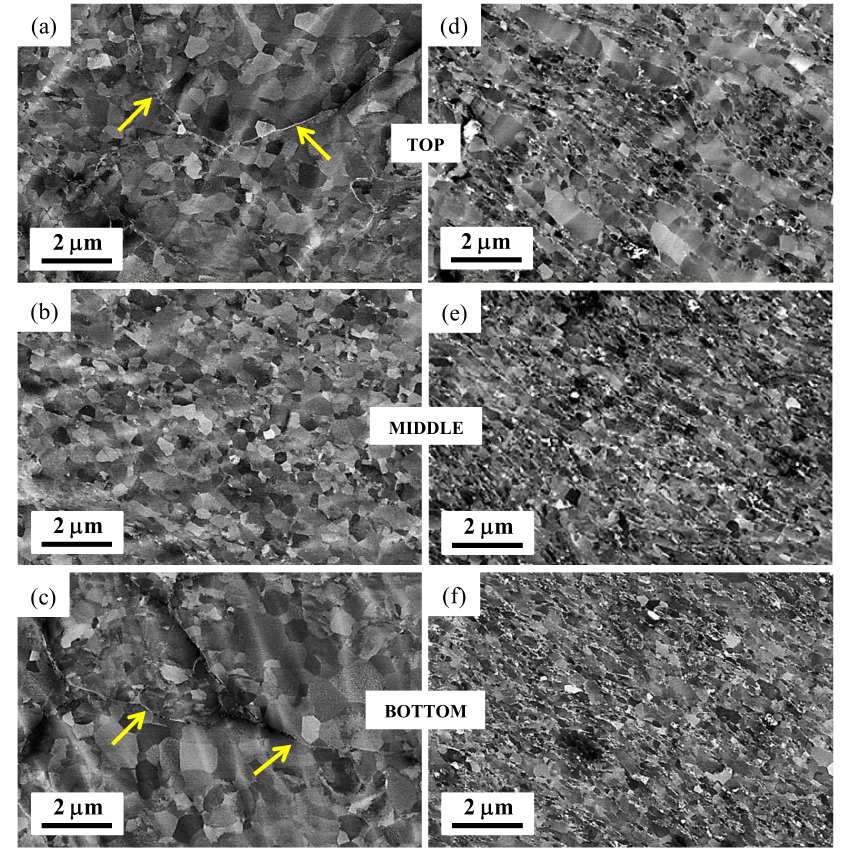
Figure 3. SEM backscattered electron micrographs acquired at the outer-edge and across the through-thickness of the 2 turns HPT disks for ( a – c ) the micro-HPT product and ( d – f ) the nano-HPT